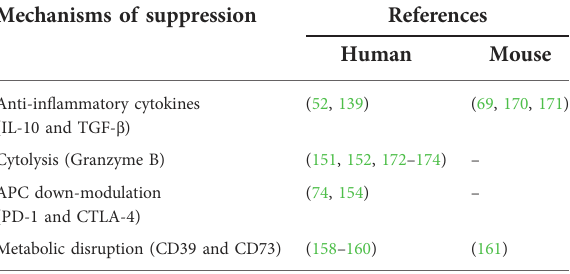
TABLE 3 Immunosuppressive roles of Tr1 cells in humans and